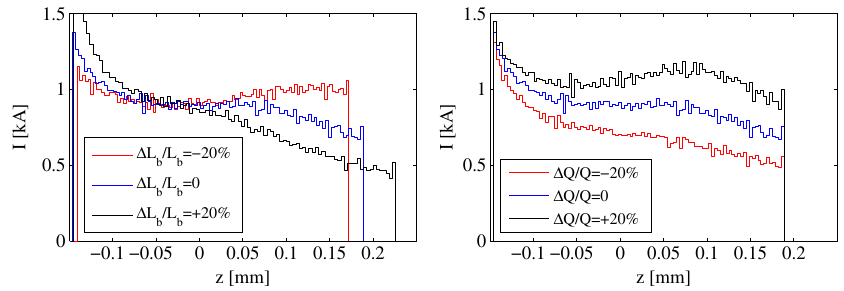
FIG. 11. (Color) Bunch current distributions after the chicane for different bunch length variations at the injector (left plot) and for different relative bunch charge variations (right